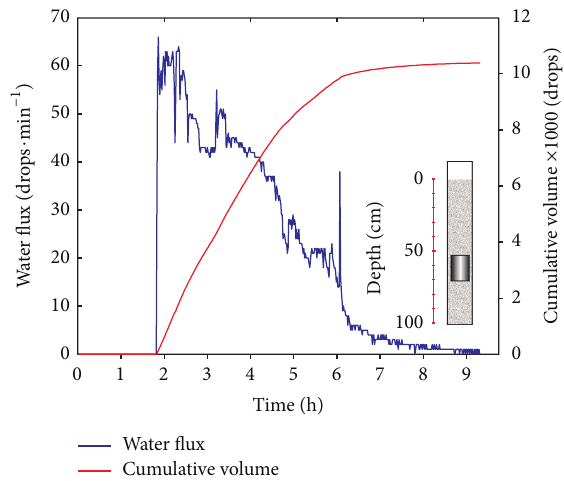
Figure 7: Graph of the vertical water flow and cumulative volume measured in the drop counter during the second infiltration